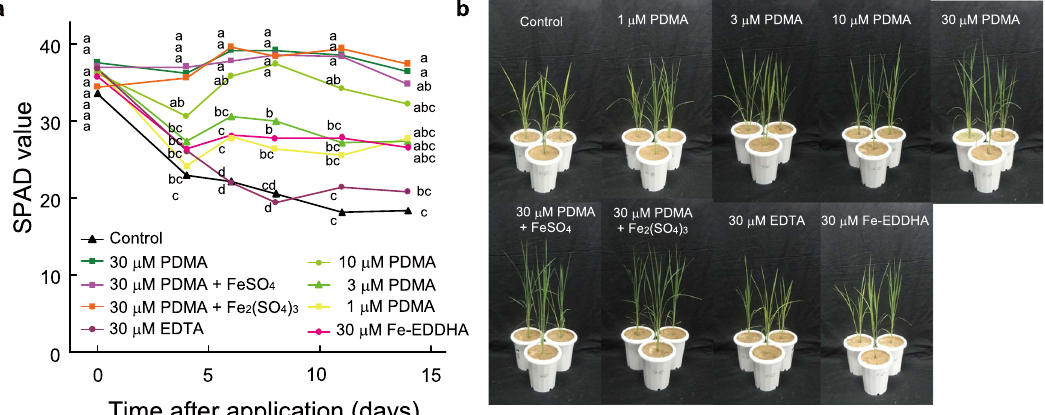
Fig. 5 Effects of unchelated PDMA on rice in calcareous soil. a SPAD values of the newest leaves after a single application of 1 – 30 µ M unchelated PDMA compared with other Fe chelates at 6 days after transplantation. PDMA was also mixed with equimolar FeSO 4 or Fe 2 (SO 4 ) 3 . Values are the means of three replicates in which each replicate is average of three plants in each pot. Different letters indicate signi fi cant differences at P < 0.05 by Tukey ’ s honestly signi fi cant difference test (two-sided). P -values for one-way analysis of variance (ANOVA) are follows: 0 days, 0.5287; 4 days, <0.0001; 6 days, <0.0001; 8 days, <0.0001; 11 days, <0.0001; 14 days, 0.0017. b Rice plants at 14 days after a single application of the Fe chelates. PDMA proline-2 ′